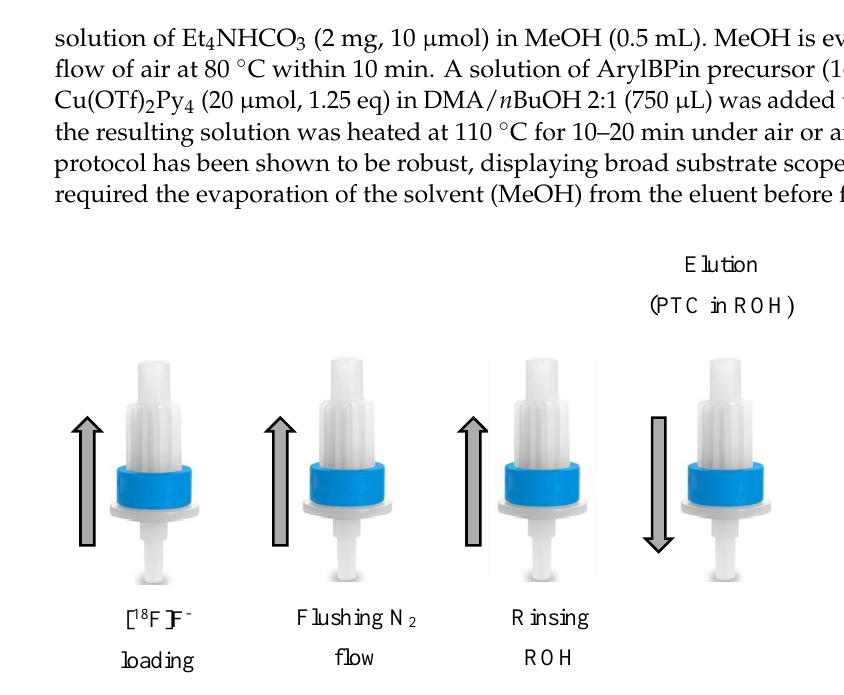
Figure 5. The schematic presentation of reverse loading-elution (back-flushed) protocol [92]. Step 1: [ 18 F]fluoride is loaded onto QMA cartridge (130 mg) from the male side; Step 2: the cartridge is flushed from the male side by nitrogen gas for 2–3 min; Step 3: the cartridge is rinsed with 2 mL of i PrOH following drying with nitrogen from the male side; Step 4: [ 18 F]fluoride is eluted from the female side using a solution of Bu 4 NOTf (5 mg, 12.5 µ mol) in i PrOH (0.8